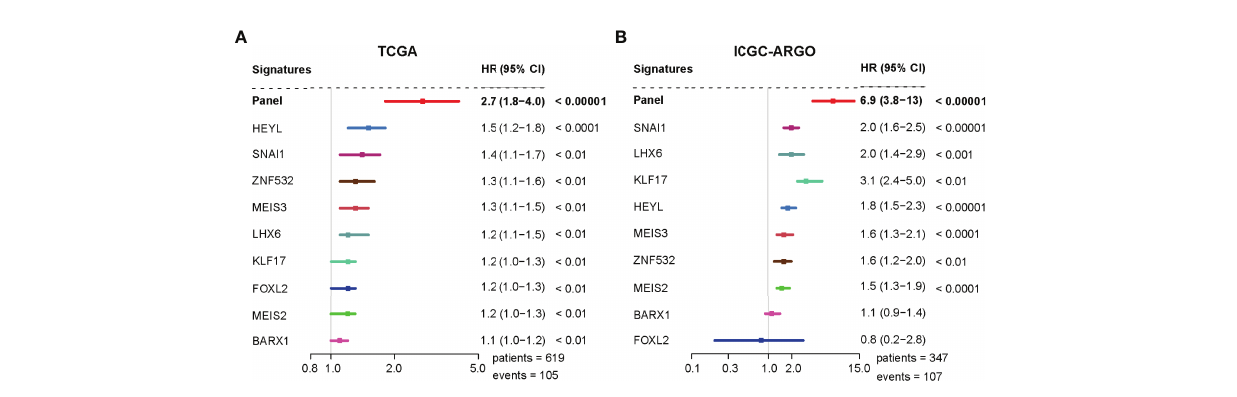
FIGURE 2 | The TF-9 signature is implicated as an independent prognostic factor in CRC. (A) Both the TF-9 signature and all nine candidate transcription factors show prognostic value in the TCGA cohort, while the TF-9 with a more signi fi cant HR (HR = 2.7, 95%CI:1.8-4.0, P < 0.001). (B) Both the TF-9 signature and all nine candidate transcription factors show prognostic value in the ICGC-ARGO cohort, while the TF-9 with a more signi fi cant HR (HR = 6.9, 95%CI: 3.8-13.0, P <